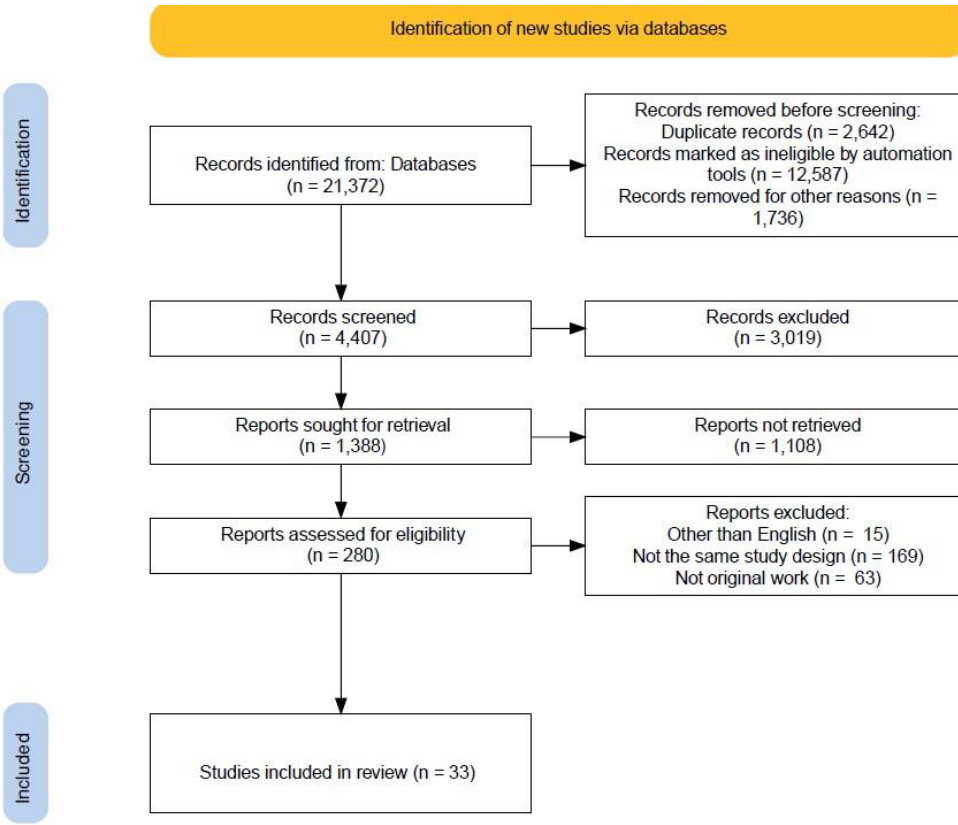
Figure 1. PRISMA Flowchart of the selection process of the reviewed studies.